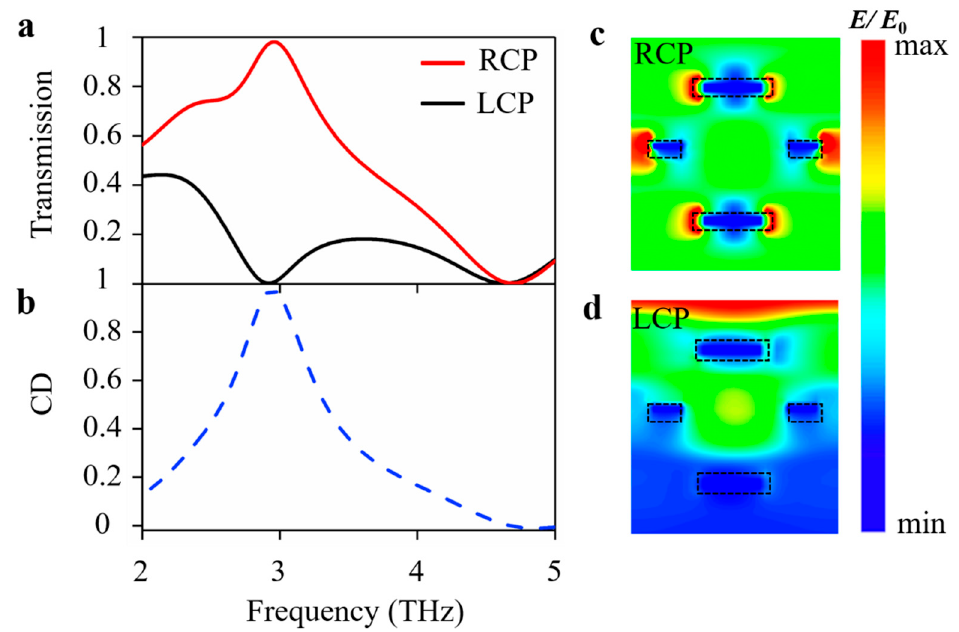
Figure 2. ( a ) The calculated transmission spectra of the proposed metamaterial and ( b ) the corre- sponding CD response for circularly polarized lights when VO 2 is in the isolating state. The side views of the electric field distributions for ( c ) RCP light and ( d ) LCP light at the resonant frequency of 2.95 THz, respectively.